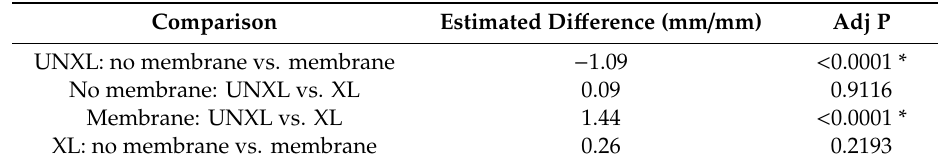
Table A5. Comparison of mean strain at break by membrane and crosslinking. * indicates statistical significance ( p <